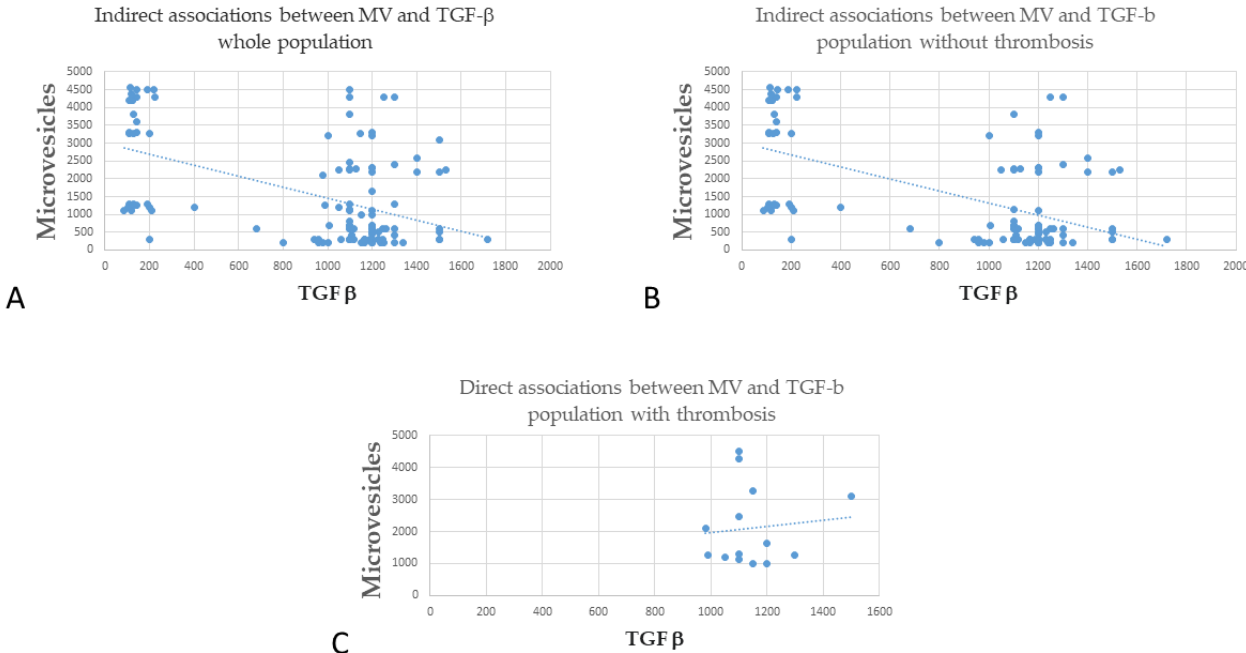
Figure 2. Correlation between MV and TGF-β ( A ) Indirect association between MV and TGF-β whole population; ( B ) Indirect association between MV and TGF-β population without thrombosis). ( C ) Direct associations between MV and TGF-β in the population with thrombosis.